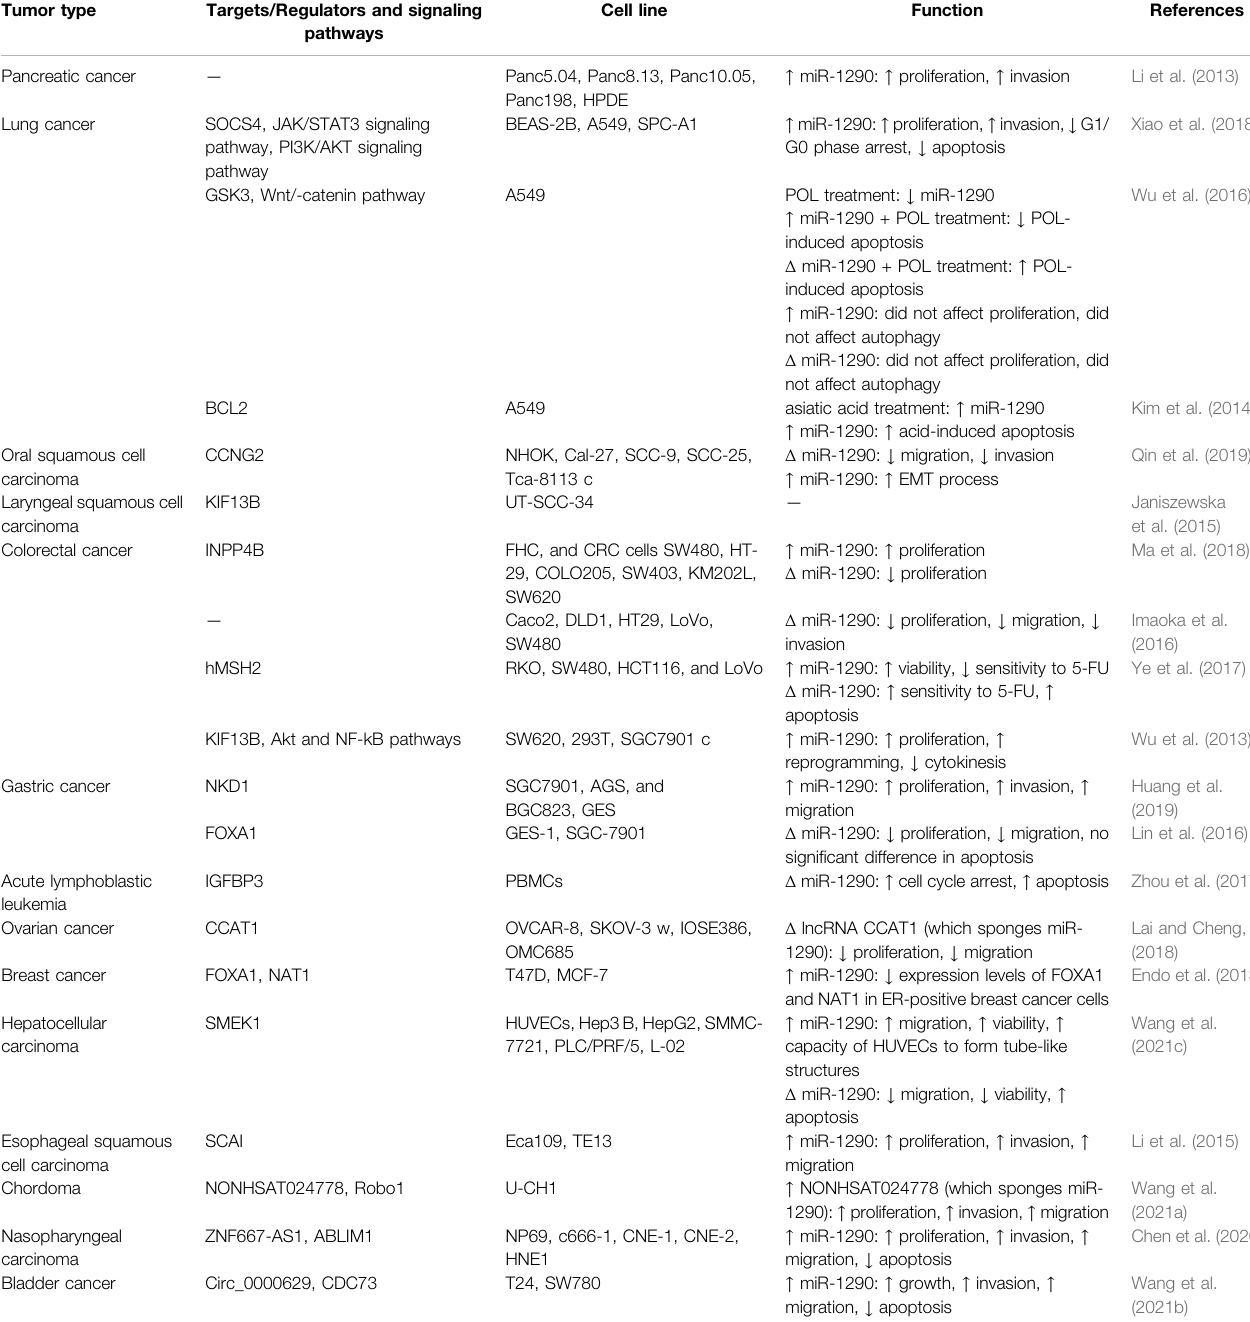
TABLE 1 | Expression pattern of miR-1290 in cancer cell lines ( Δ : knock-down or deletion, POL: Polygonatum odoratum lectin, 5-FU: